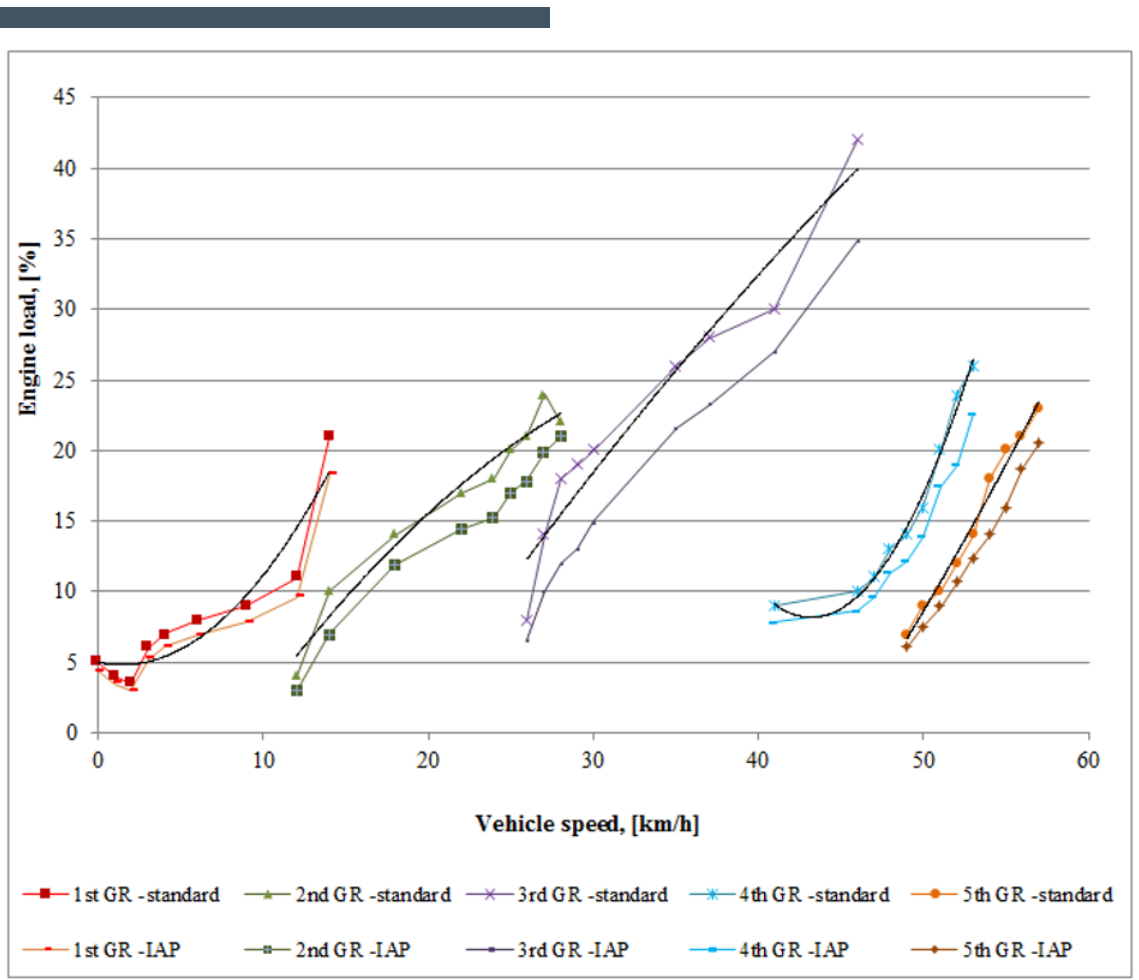
Figure 8. Engine load versus vehicle speed for different gear